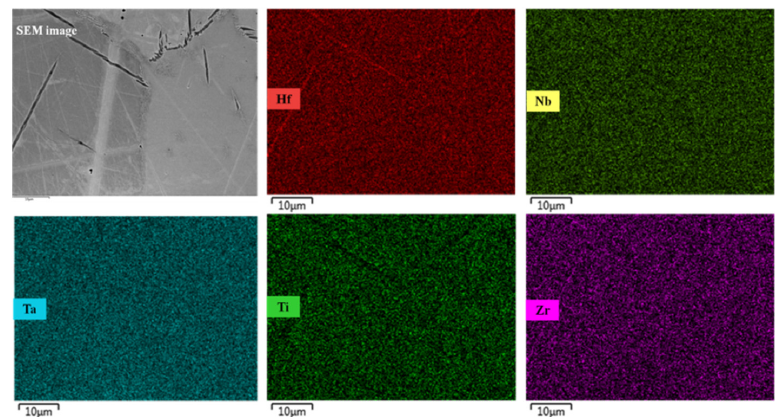
Figure 4. Representative compositional EDS mapping results for the HfTaTiNbZr sample consolidated at 1300 °C ( τ = 10 min).